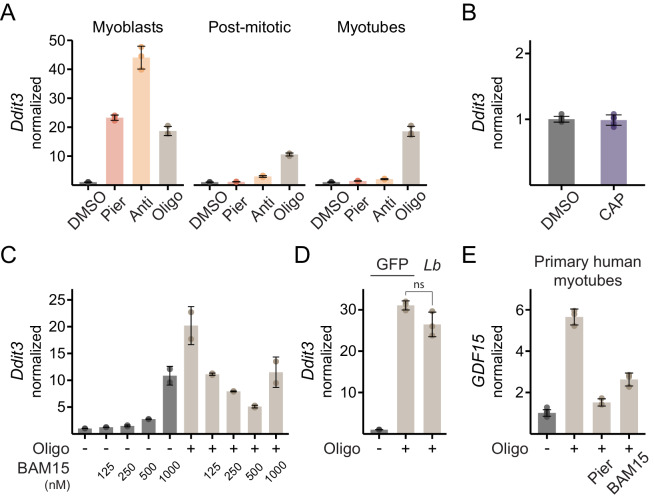
Additional data on ISR activation in myotubes.(A) qPCR of Ddit3 following 10 hr inhibitor treatments in C2C12 myoblasts, post-mitotic cells and myotubes. Data is normalized to DMSO separately in each panel. Mean ± SD, N = 3 (myoblast samples are a subset of those previously shown in Figure 3E and myotube samples are a subset of those previously shown in Figure 5B). (B) qPCR of Ddit3 in myotubes treated for 48 hr with chloramphenicol (CAP). Data is presented as fold-change from DMSO. Mean ± SD, N = 5–6. (C) qPCR of Ddit3 in myotubes treated for 10 hr with DMSO or oligomycin in the presence of the indicated concentration of BAM15. Data is normalized to DMSO (-) with no BAM15. Mean ± SD, N = 2. (D) qPCR of Ddit3 in myotubes expressing GFP or LbNOX (Lb) and treated with oligomycin for 10 hr. Data is normalized to DMSO (-) in GFP. Mean ± SD, N = 3. Welch’s t-test (two-tailed) was used to compare oligomycin-treated samples expressing GFP and LbNOX. ns, p>0.05. See also Supplementary file 1. (E) qPCR of GDF15 in primary human myotubes treated for 10 hr with oligomycin alone, in combination with piericidin or in combination with BAM15. Data is presented as fold-change from DMSO. Mean ± SD, N = 3–6.